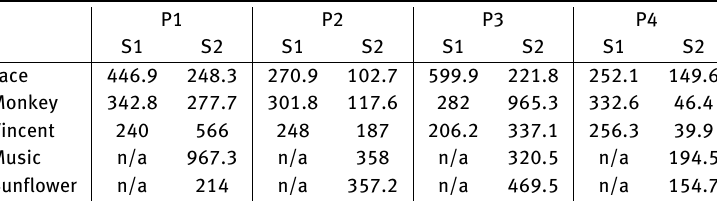
Table 6. Total time spent at each exhibit (seconds) by each participant during Sessions 1 and 2. Note that during S1, only the Face, Monkey, and Vincent exhibits were available for viewing. During S2, all exhibits could be